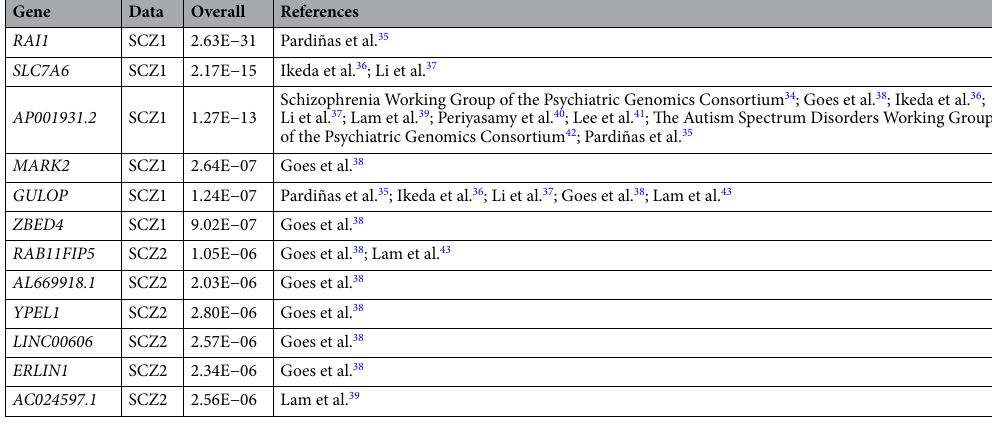
Table 4. Genes identified only by Overall based on the two SCZ data sets that are reported in the GWAS